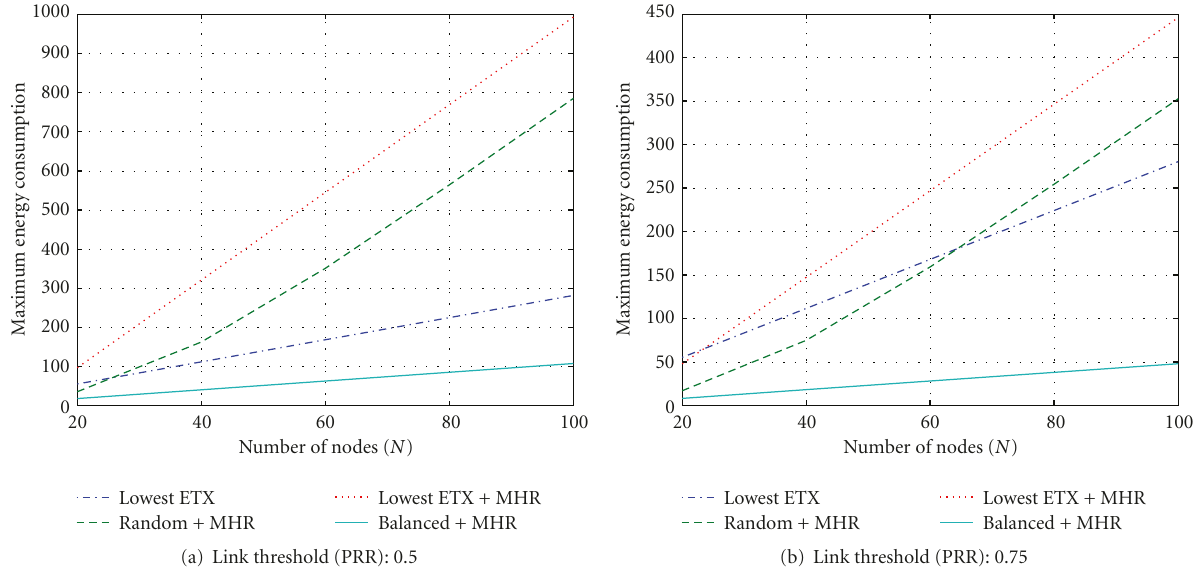
Figure 11: The maximum energy consumption as a function of the network size (i.e., the total number of nodes, N , in a network).